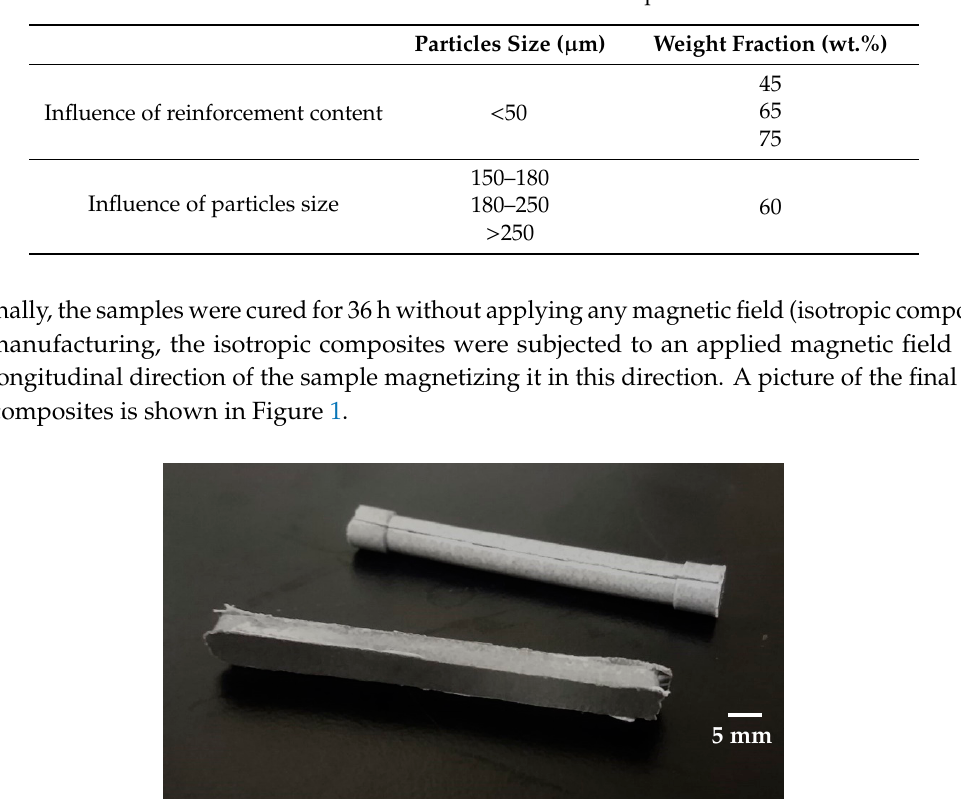
Table 1. Parameters of manufactured composites.